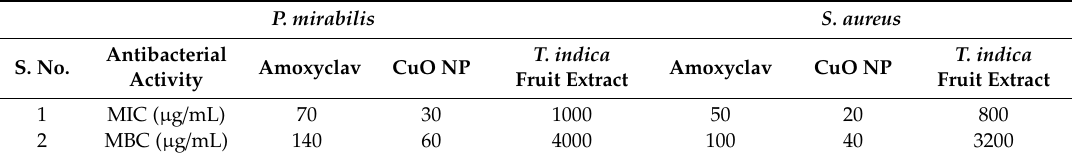
Table 3. Antibacterial activity of amoxyclav and CuO